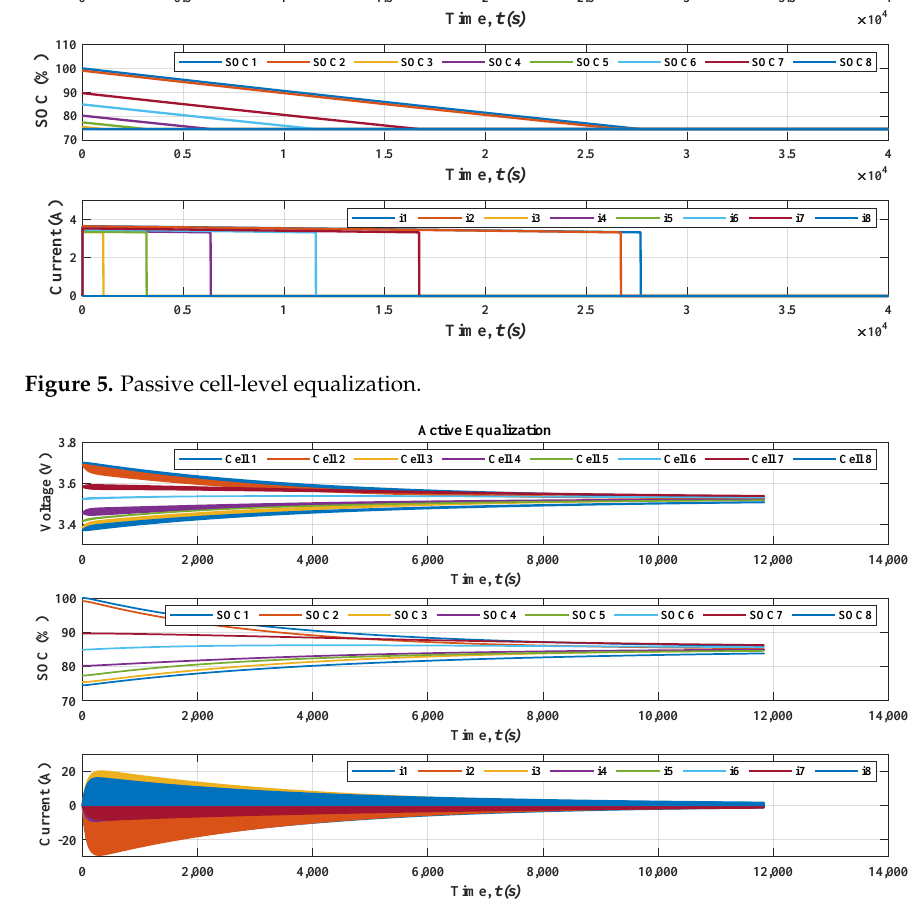
Figure 6. Active cell-level